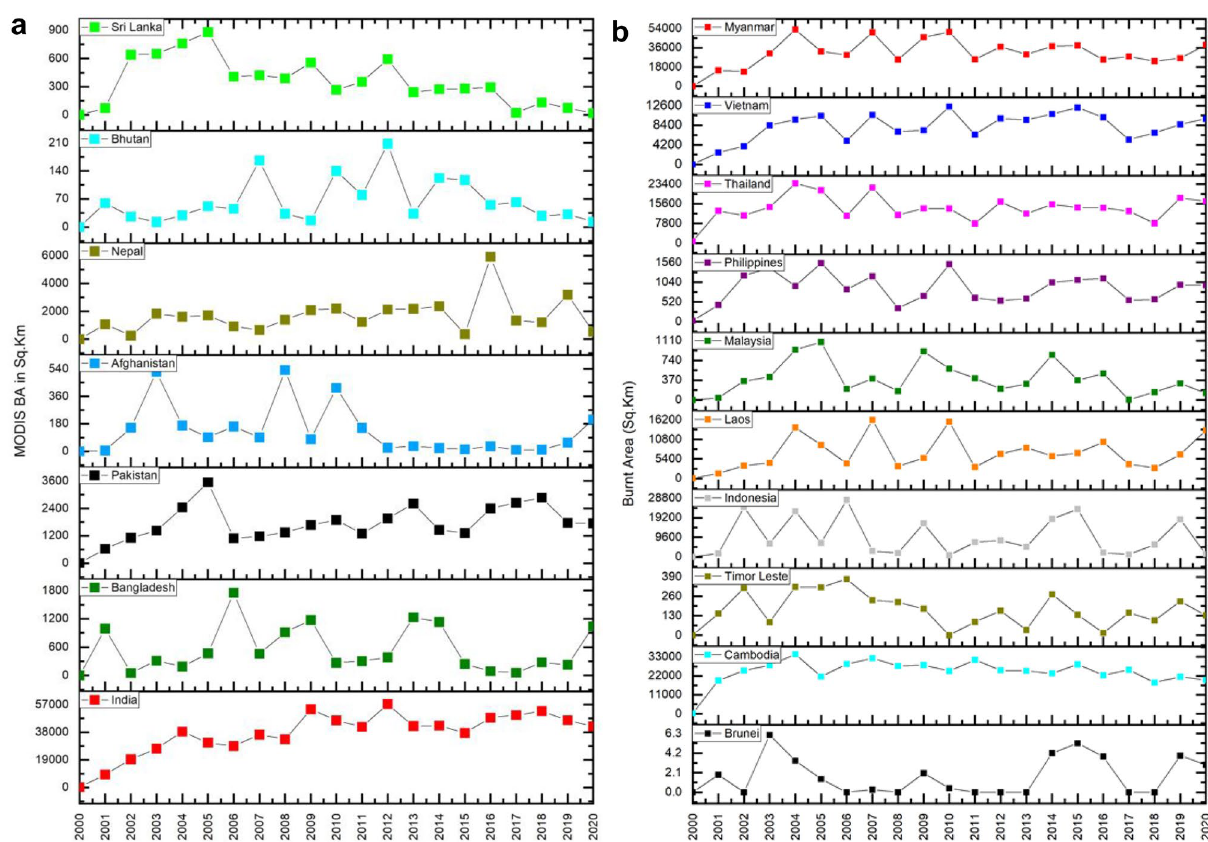
Figure 3. ( a ), ( b ). Burnt areas (in sq.km) for different countries in South Asia (10a) and Southeast Asia (10b).